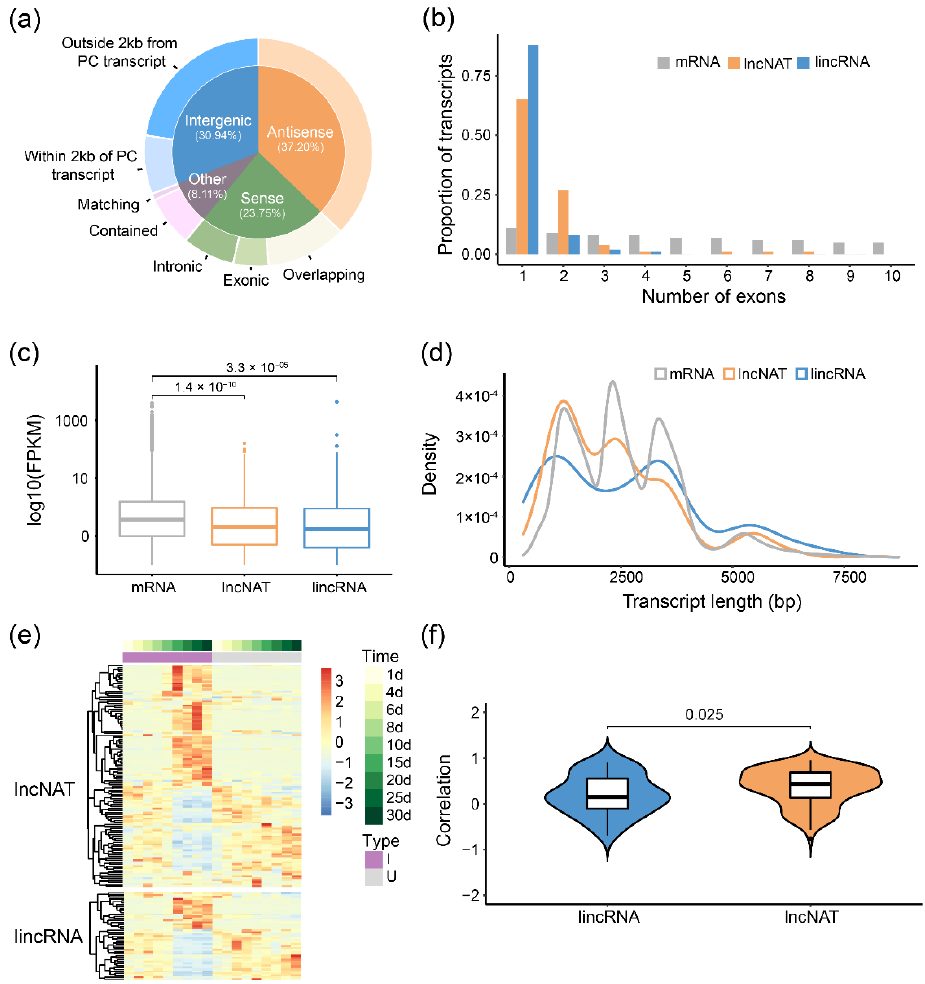
Figure 4. Characteristics of long non-coding RNAs in soybean root and nodule tissues. ( a ) Classification of lncRNAs according to their intersection with JD17-annotated protein-coding transcripts on the genome. There are four part of these categories and eight subcategories; ( b – d ) lincRNAs and lncNATs were compared to Iso-Seq-detected mRNA on ( b ) exon numbers per transcript, ( c ) expression levels and ( d ) length distributions. Grey stands for mRNA, red for lncNATs (antisense lncRNAs), blue for lincRNAs (intergenic lncRNAs without 2 kb of protein-coding transcripts). Wil- coxon test was used; ( e ) Expression patterns of 157 differentially expressed lincRNAs and lncNATs; ( f ) The spearman correlation coefficient (SCC) of expression pattern between differentially ex- pressed (DE) lncRNA and corresponding protein-coding (PC) transcripts (lncNATs with anti-strand PC transcripts and lincRNA with adjacent PC transcripts) across the root and nodule development. Wilcoxon test was used. 3. Discussion In this study, we explored complicated post-transcriptional regulation during soy- bean nodulation by Iso-Seq. First, we found that transcripts from soybean underground tissues are greatly longer and more abundant than the annotated transcripts of soybean JD17 genome [40] (Annotation with PacBio Iso-Seq datasets from Glycine max cv. Williams 82 mixed tissue [41]), probably because of deeper sequencing depth (52 vs. 23 SMRT cells) and longer library length. Second, we identified nearly 8000 differentially splicing events after inoculation and obtained dynamic AS profiles. Moreover, thousands of genes with major isoforms switches between different conditions were discovered and analyzed, which provides novel evidence for the AS-influenced nodule formation and development in soybean. Finally, by identifying poly(A)+ full-length lncRNAs from Iso-Seq data, we